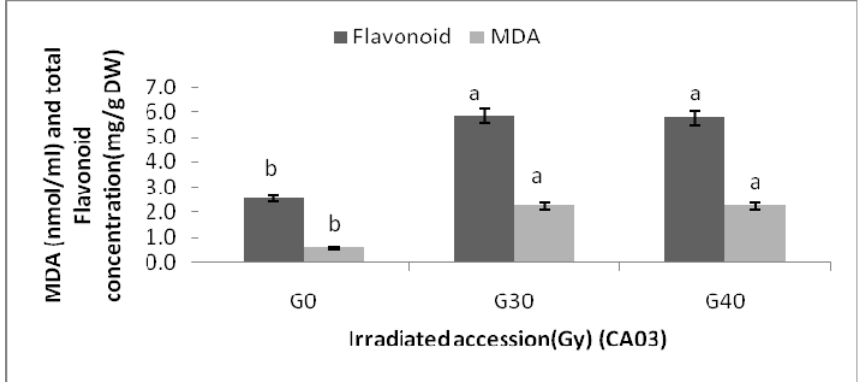
Figure 4. Flavonoid content and MDA in irradiated and non-irradiated accessions of CA03 n = 3 (CA03G30 = CA03 irradiated to 30 Gy; CA03G40 = CA03 irradiated to 40 Gy). Notice: Each observation compared with its